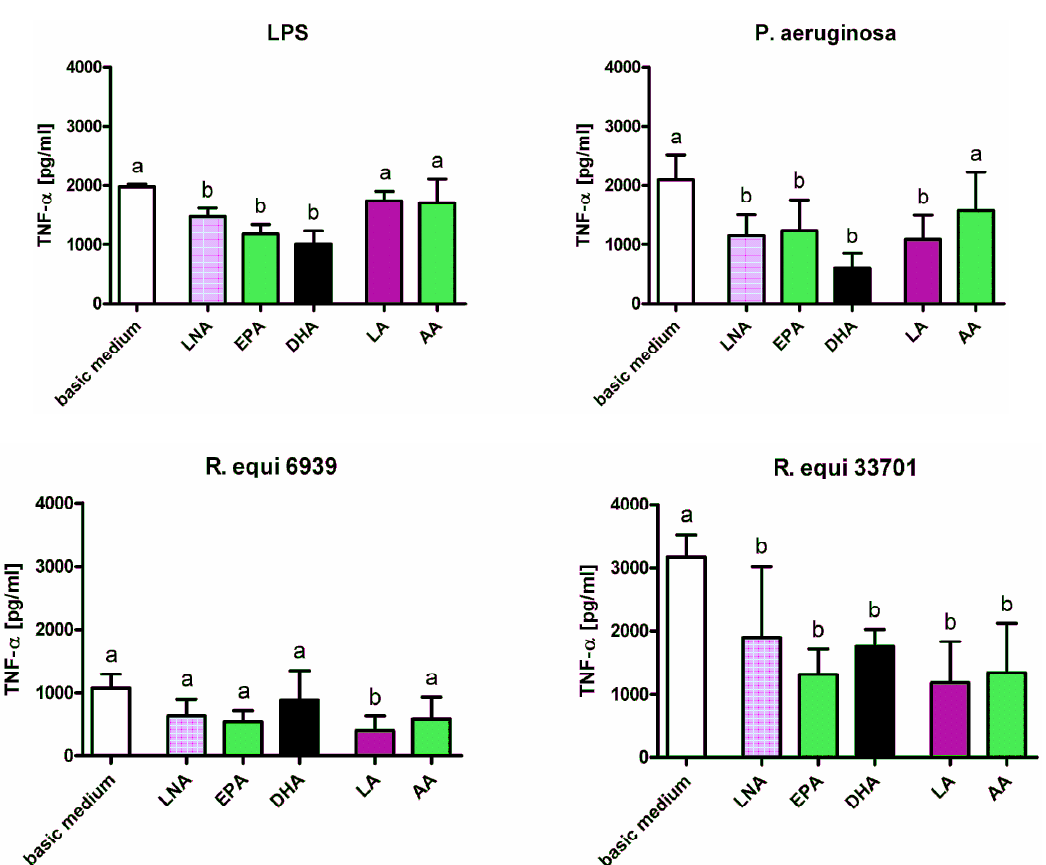
Figure 4. Concentration of TNF- α in supernatants of RAW264.7 macrophages cultured in basic medium as well as in medium supplemented with 15 µmol/L alpha-linolenic acid (LNA), eicosapentaenoic acid (EPA), docosahexaenoic acid (DHA), linoleic acid (LA) or arachidonic acid (AA) after 24 h of stimulation with LPS, P. aeruginosa ATCC 10145, R. equi ATCC 6939 and R. equi ATCC 33701 respectively. Data are mean ± SD ( n = 6). Bars denoted by different letters are significantly